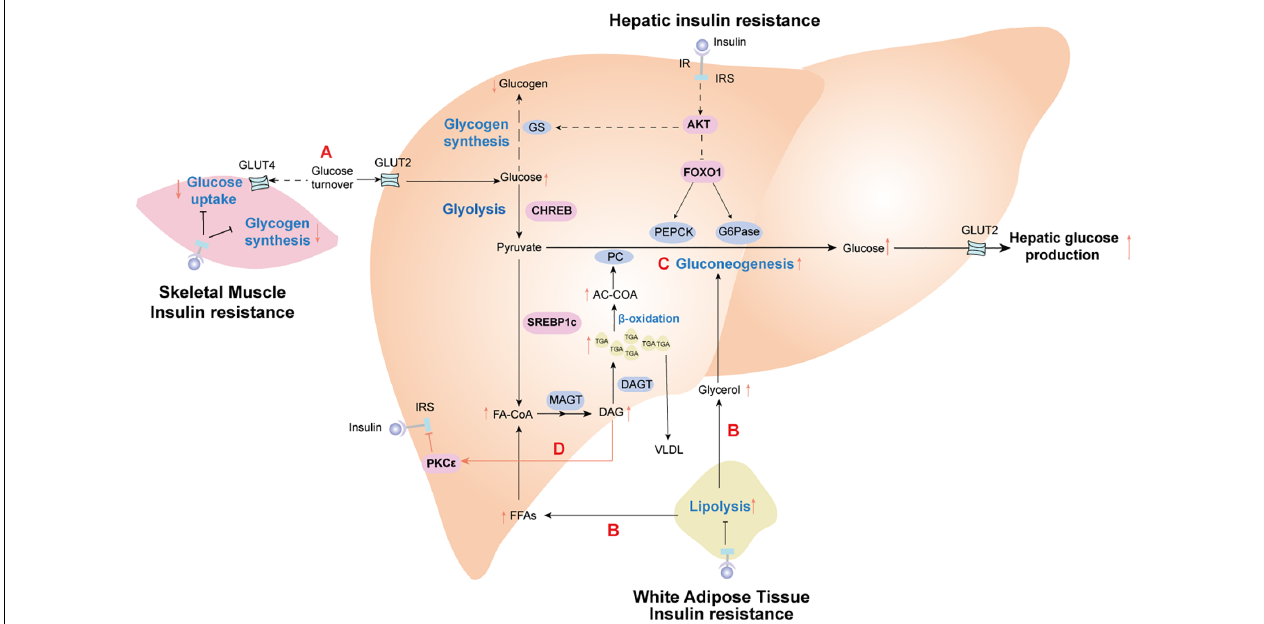
FIGURE 1 | Insulin resistance effect profiles in the metabolic cross-talk network between liver and peripheral tissues. (A) Skeletal muscle insulin resistance impairs insulin-stimulated muscle glucose uptake, resulting in increased glucose delivery to the liver. (B) Adipose insulin resistance impairs insulin-mediated suppression of lipolysis, leading to the release of glycerol and fatty acid (FAs). These nutrients are further redirected to the liver, driving hepatic lipid synthesis and activating hepatic gluconeogenesis. (C) In the liver, increased fatty acid oxidation activates hepatic gluconeogenesis via acetyl-CoA-mediated activation of pyruvate carboxylase (PC), while glycerol delivery to the liver increases gluconeogenesis via a substrate push. (D) Diacylglycerol (DAG)-mediated activation of protein kinase C epsilon (PKC ε ) impairs hepatic insulin signaling, thereby constraining insulin-stimulated hepatic glycogen synthesis. Hepatic lipid synthesis continues unabated. The net results of these changes are the root cause of hepatic selective insulin resistance, which is characterized by decreased hepatic glycogen synthesis and increased hepatic gluconeogenesis and hepatic lipid synthesis. IR, insulin receptor; IRS, insulin receptor substrate; PEPCK, phosphoenolpyruvate carboxykinase; G6Pase, glucose 6-phoshase. Solid black lines stand for the normal metabolic pathways. Black dotted lines and red solid lines represent the metabolic pathways of pathological states.